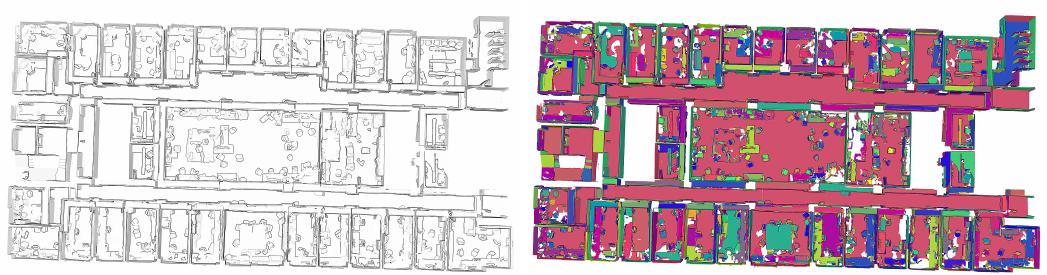
Figure 2. Point Cloud Segmentation results on Area 1 of the Stanford 2D-3D-Semantics Dataset (2D-3D-S)